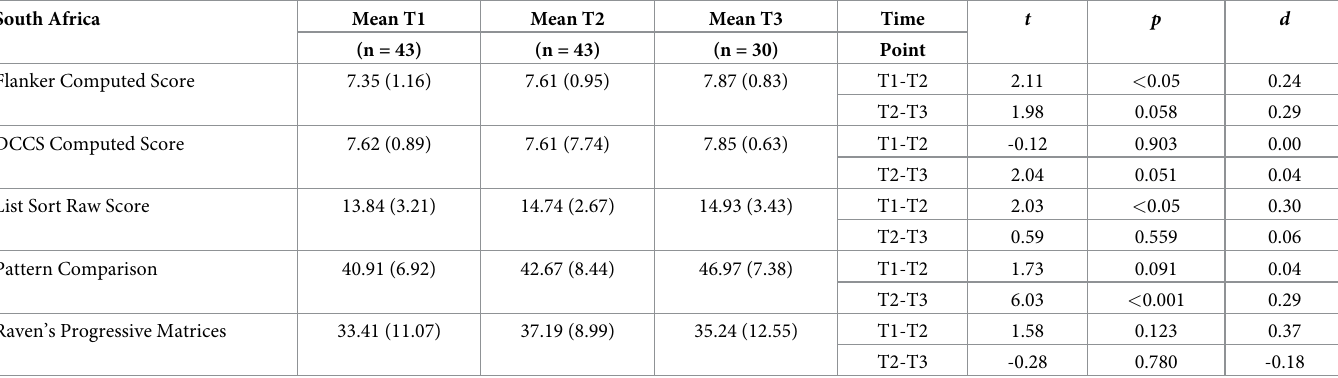
Table 7. Mean (SD) for assessment scores over time for South